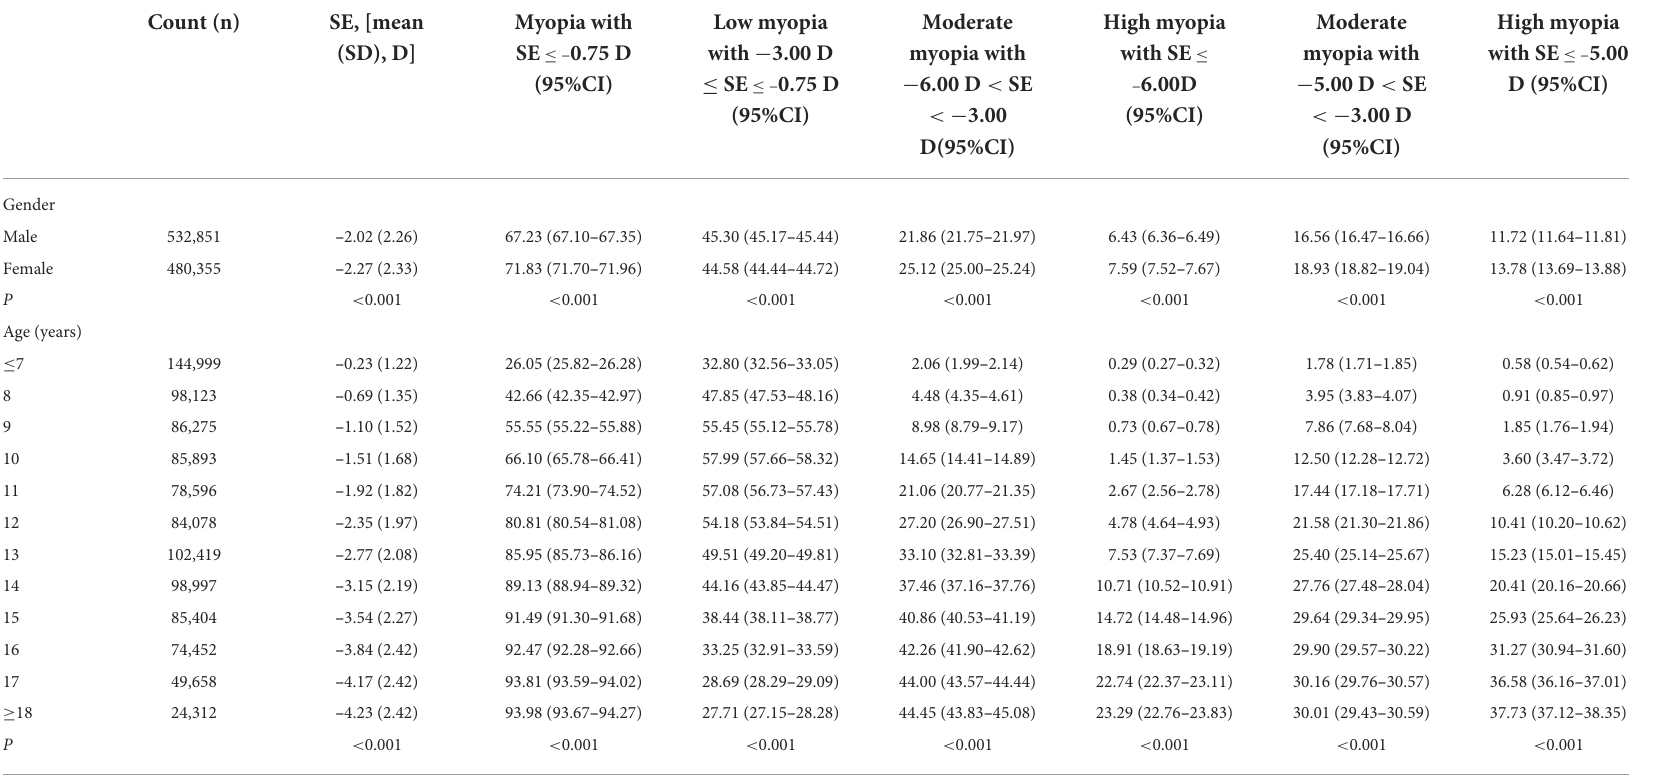
TABLE 2 Distribution of different grades of myopia stratify by gender and age